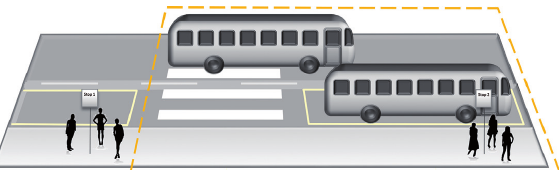
Figure 9: An independent linear bus stop with an adjacent driving lane and a pedestrian crossing. The dashed rectangle marks the part included in one module.